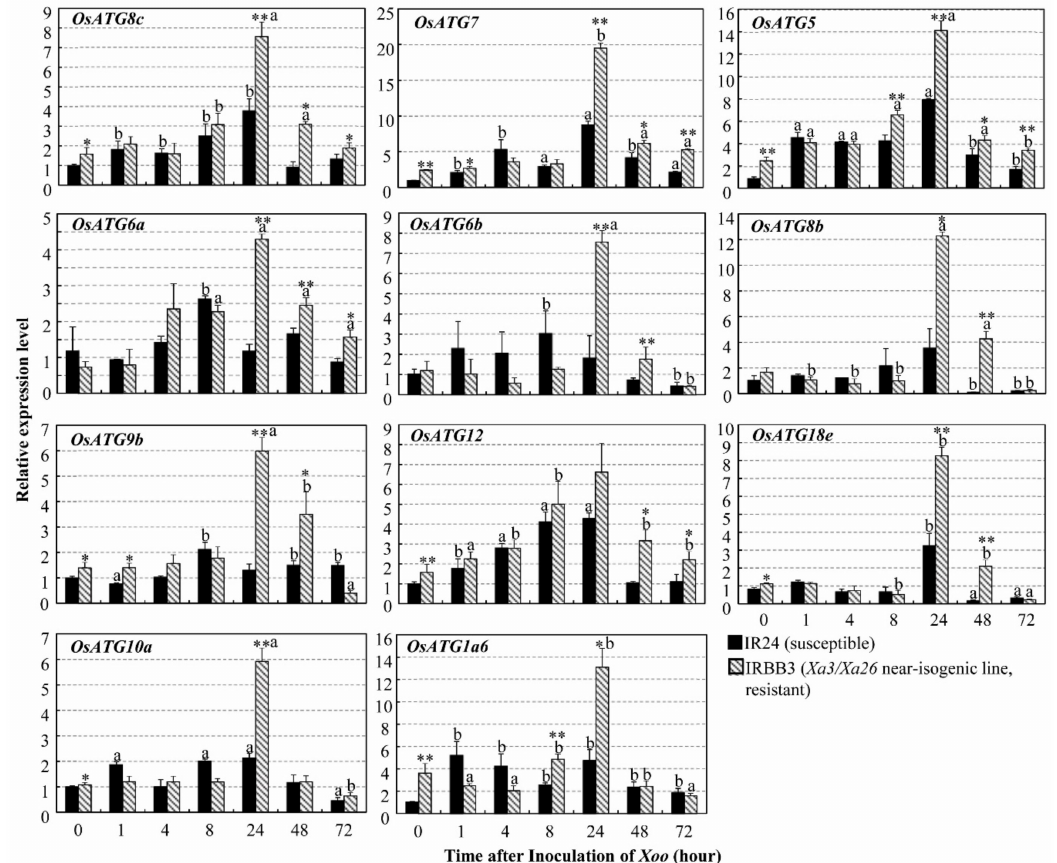
Figure 2. Autophagy-related gene ( ATG ) expression level in Xa3 / Xa26- mediated resistance. Expression of autophagy-related genes analyzed by qRT-PCR in resistant (IRBB3) and susceptible (IR24) rice plants. Rice plants were inoculated with Xoo strain PXO61 at tilling stage. Data are presented as mean (three replicates) + standard deviation (SD). Letters “a” and “b” indicate statistically significant di ff erences between 0 h and other time at p < 0.01 and p < 0.05, respectively in same rice plants. Double asterisks (** p < 0.01) and single asterisk (* p < 0.05) indicate di ff erent levels of statistical significance between IRBB3 and IR24 inoculated at the same time